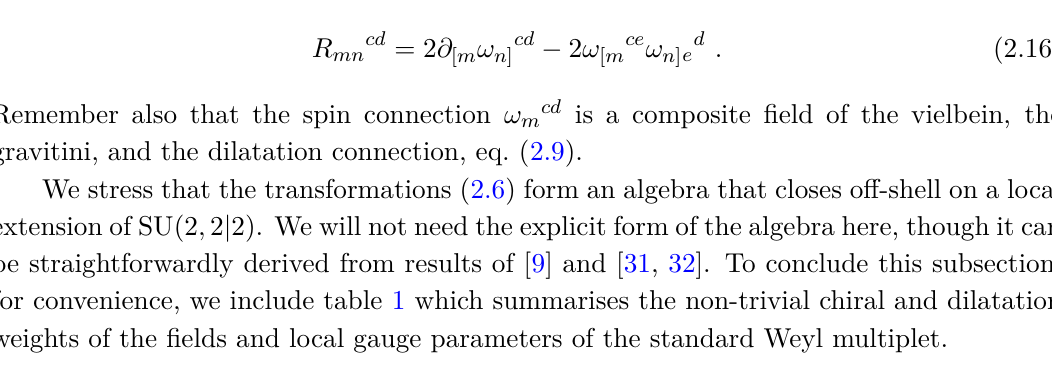
Table 1 . Summary of the non-trivial dilatation and chiral weights in the standard Weyl multiplet. where R = e am e bn R mnab is the scalar curvature constructed from the Lorentz